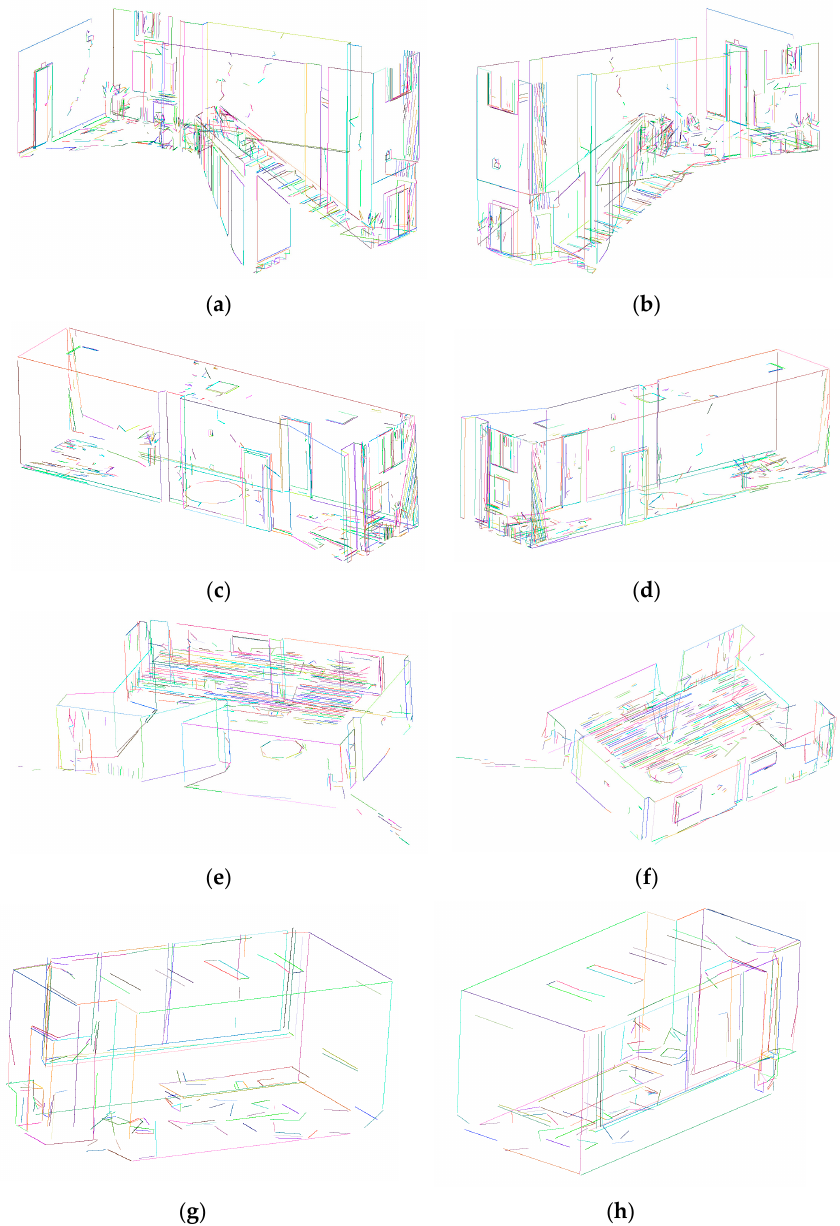
Figure 14. Three-dimensional line segments extracted by the method of Lu et al. [25]. Each scene is shown from two angles. ( a , b ) Staircase. ( c , d ) Corridor. ( e , f ) Laboratory. ( g , h ) Lounge.